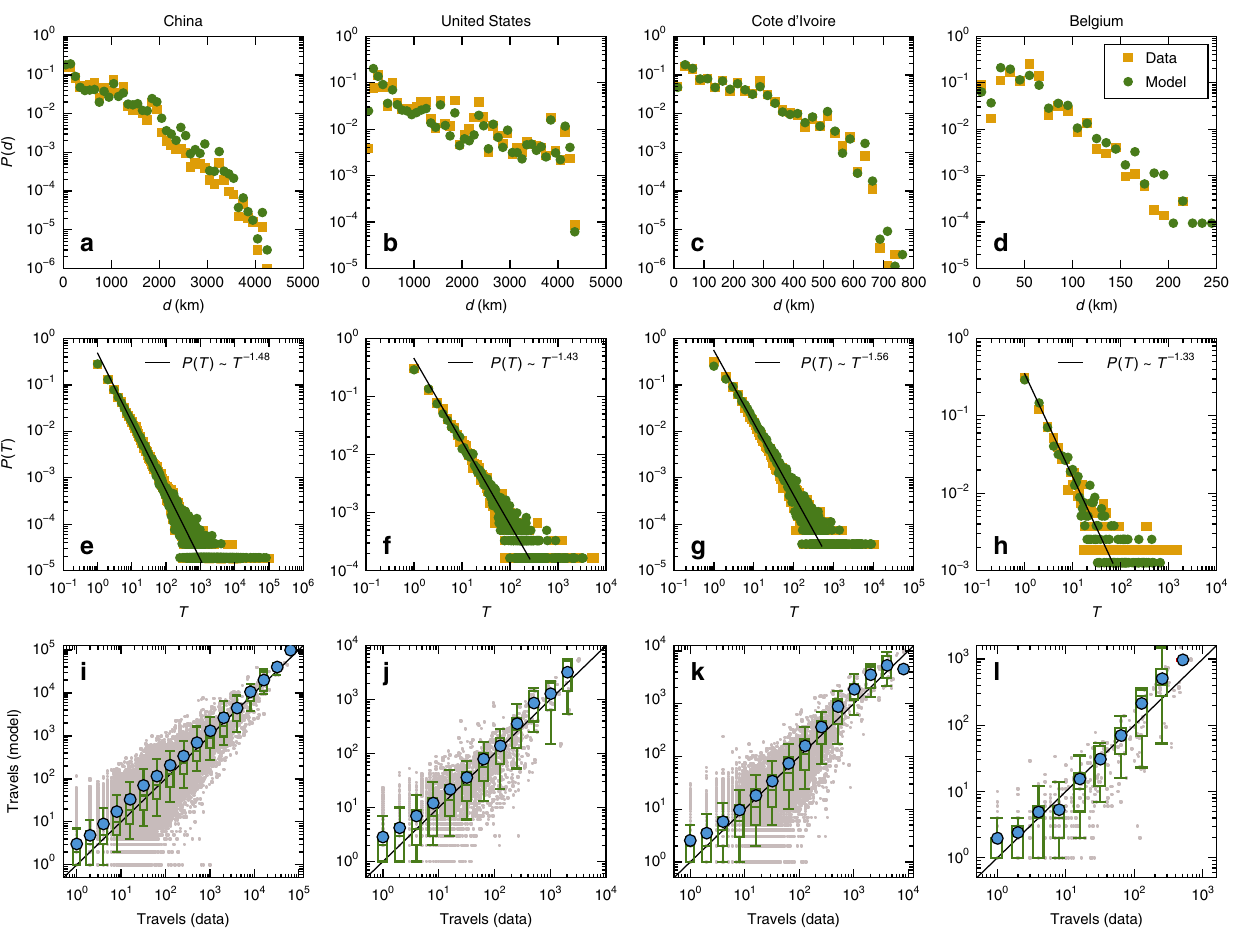
Fig. 5 Model prediction at the population level and validation. For the four empirical data sets with vast difference in the spatial scale, model-predicted and real distributions of travel distance d ( a – d ) and the number of traveling steps, T , between two locations e – h . The lines in e – h represent a power-law fi t to the real data. i – l Statistical display of the model-predicted and real values of T for the four data sets, respectively, which are nearly indistinguishable. The gray points are scatter plot for each pair of locations. The blue points represent the average number of predicted travels in different bins. The standard boxplots represent the distribution of the number of predicted travels in different bins of the number of observed travels. A box is marked in green if the line y = x lies between 10% and 91% in that bin and in red by the previous evidence that there are situations where